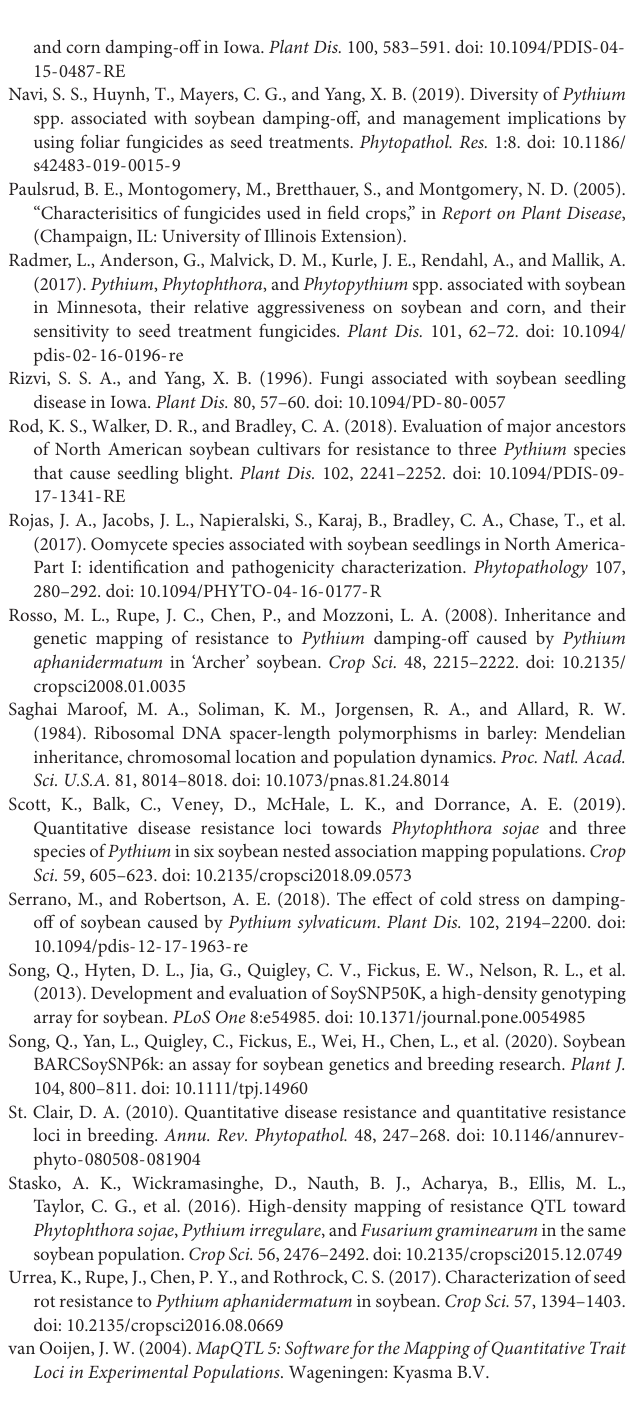
large effect QDRL is in the same chromosomal region as the large effect QDRL after P. sylvaticum inoculation in this same population. The two traits had CIM LOD scores of 11.9 and 2.6. The closest QDRL marker for this large effect QDRL is Gm06_31863080_C_T. Supplementary Table 1 | A summary of the SNP marker number per chromosome for each of the four populations, the map marker density for each population, and the total number of markers mapped for each